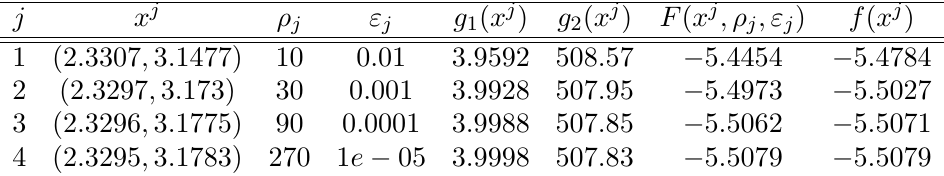
Table 2. Table of minimization process of the Problem 2.